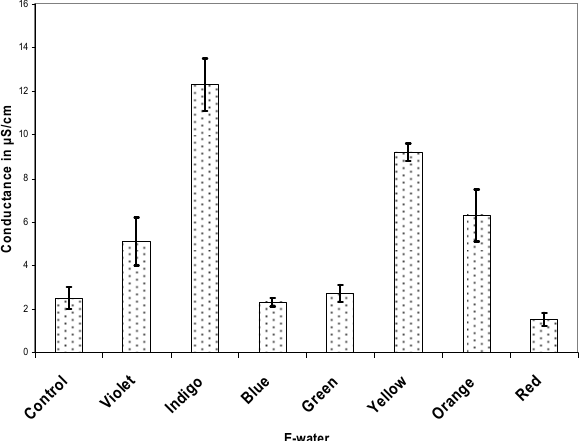
Figure 4: The Conductivity of different E-waters using conductance meter (Wheatstone Bridge). Measurements were taken in triplicate and are represented as Mean ± SD.